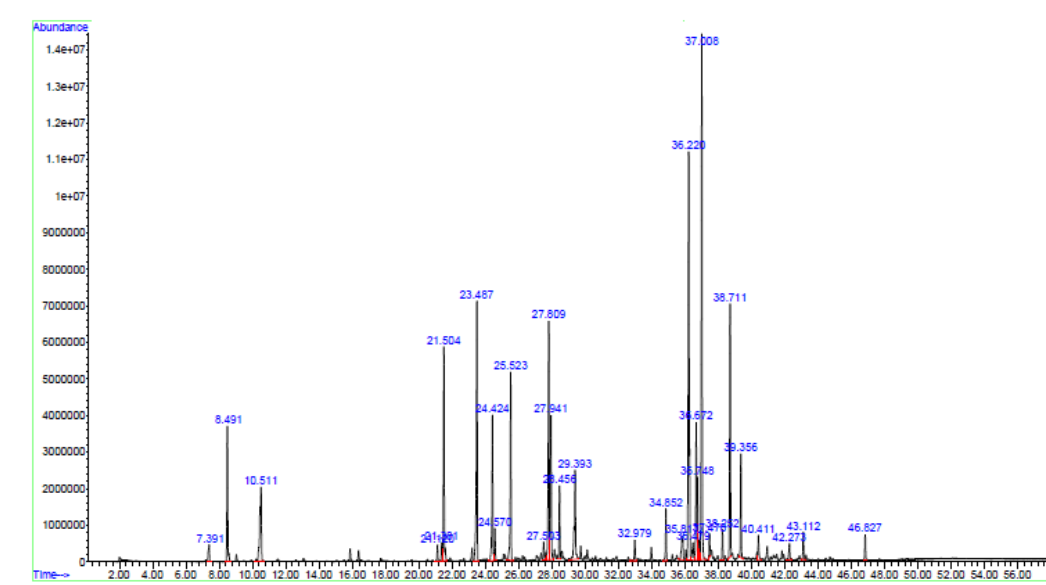
Figure 2. Gas chromatogram of the essential oil of ‘Koçarlı’ purple